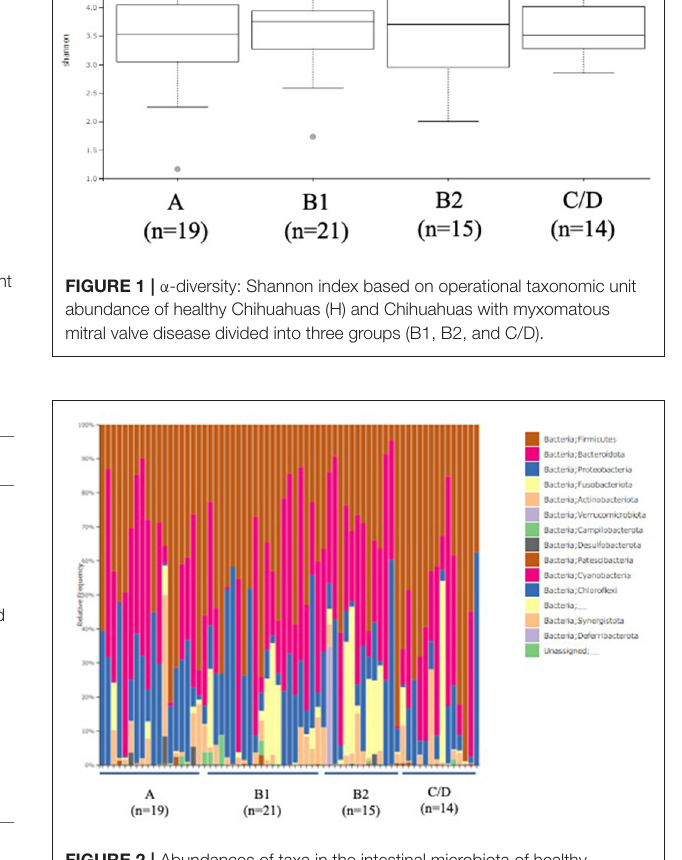
FIGURE 2 | Abundances of taxa in the intestinal microbiota of healthy Chihuahuas (H) and Chihuahuas with myxomatous mitral valve disease divided into three groups (B1, B2, and C/D) (phylum